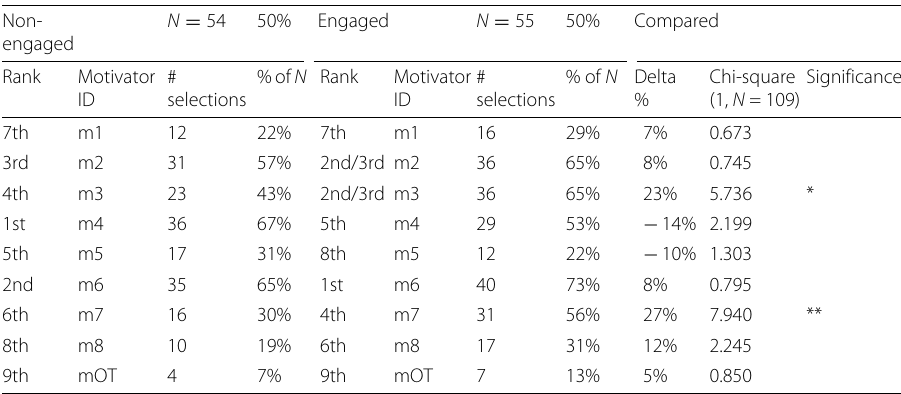
Table 12 Comparison of ranking of motivators for IoT application development and deployment for non-engaged and engaged enterprises based on selection frequency Non- N = engaged